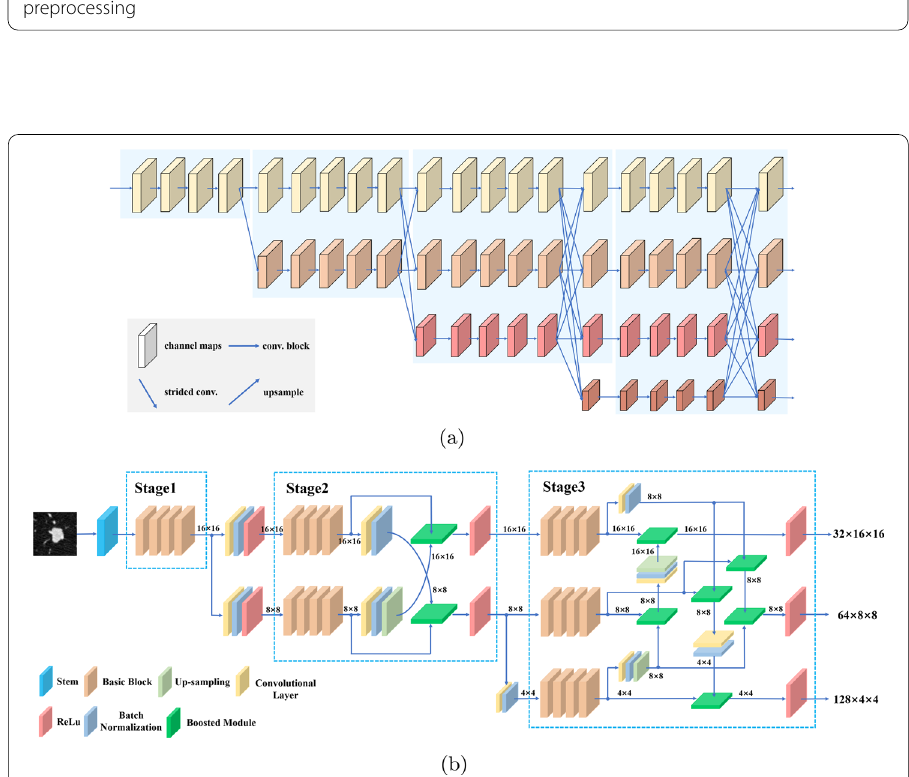
Fig. 3 The architecture of the networks: a the HRNetV2 [3]; b the proposed HR-MPF network consists of three stages (blue boxes). This is a multi-scale progressive fusion network with boosted modules incorporated. The fusion is implemented from high-to-low or low-to-high resolution so that the spatial and context information of features of all resolutions are fully engaged. The size of the feature map in each path is also